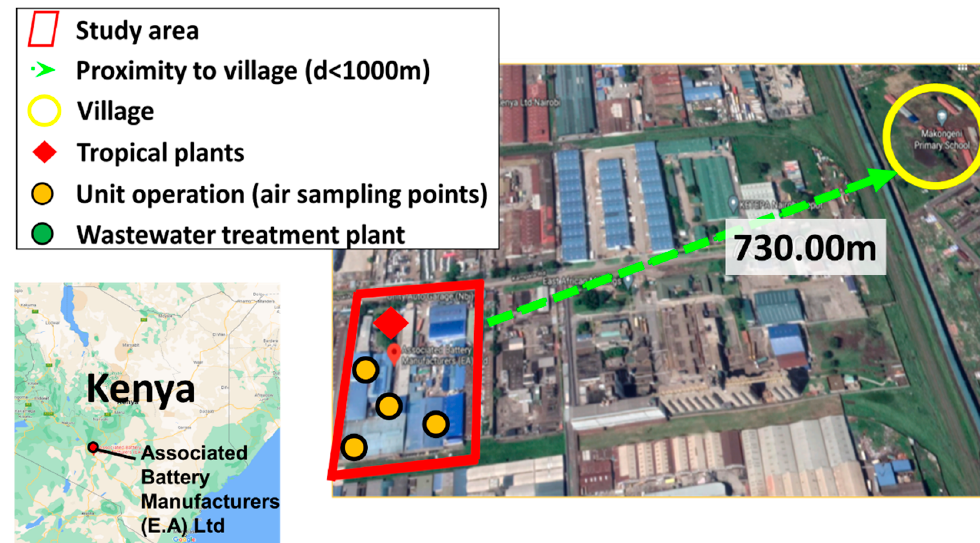
Figure 1. Research area regarding proximity to villages of Associated Battery Manufacturing and location of lead sampling points, Associated Battery Manufacturing (East Africa) Limited, Nairobi, Kenya.